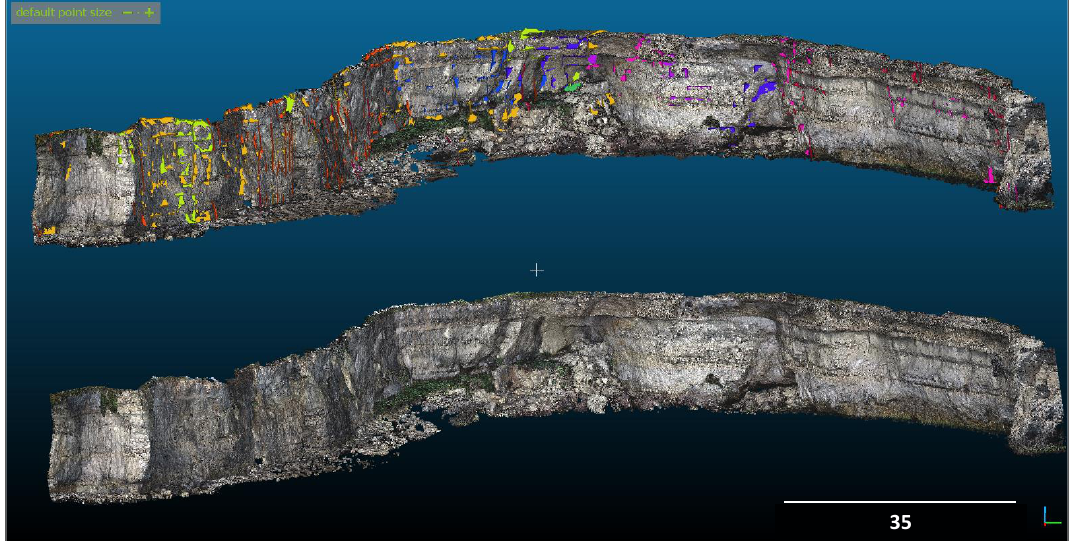
Figure 15. Superficial fractures systems with a tool for facet/fracture detection.